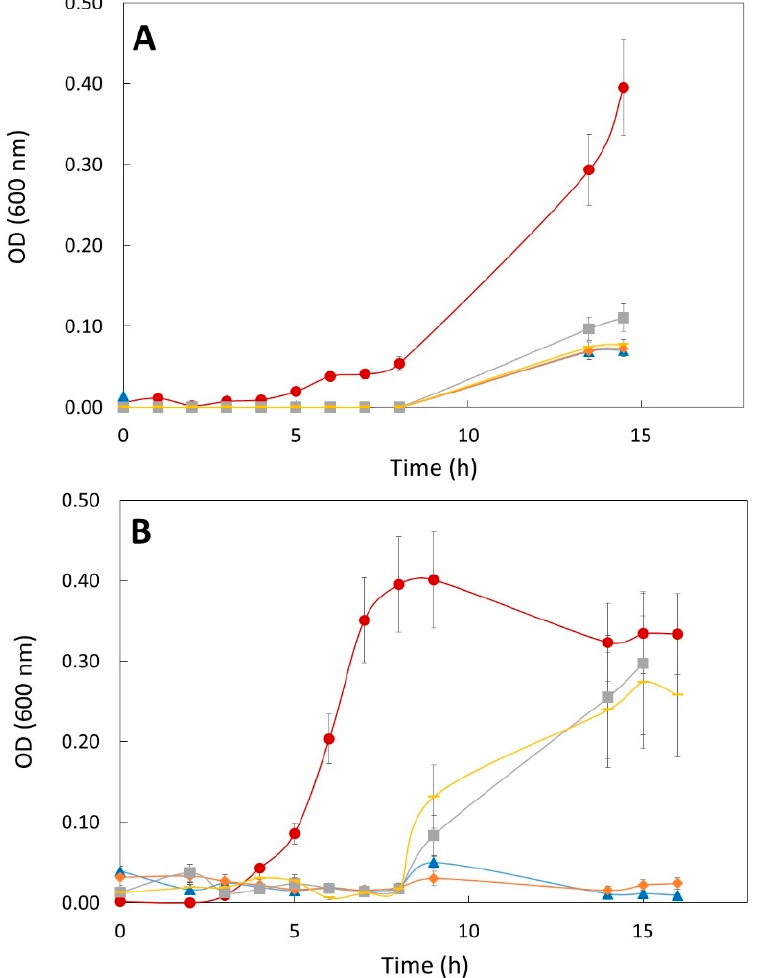
Figure 1. Growth curves of Listeria monocytogenes at room temperature ( A ) and at 37 ◦ C ( B ): • no films; (cid:78) CH 2% films; (cid:7) CH 2% + OLE 10% films; (cid:4) CH 2% + OLE 20% films; – CH 2% + OLE 30% films.